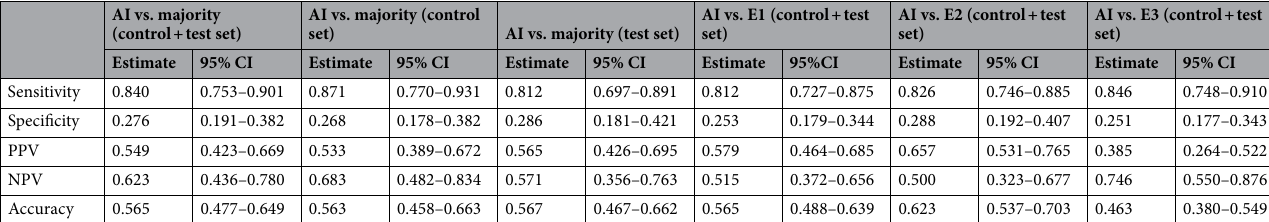
Table 1. Operating characteristics and 95% confidence intervals for AI versus evaluators. “AI vs. Majority” compares AI with panel majority of the 3 evaluators: E1, E2, and E3. “Control” refers to the first set of 10 unassisted squat repetitions. “Test” refers to the third and last set of 10 unassisted squat repetitions performed by participants after receiving feedback in the second